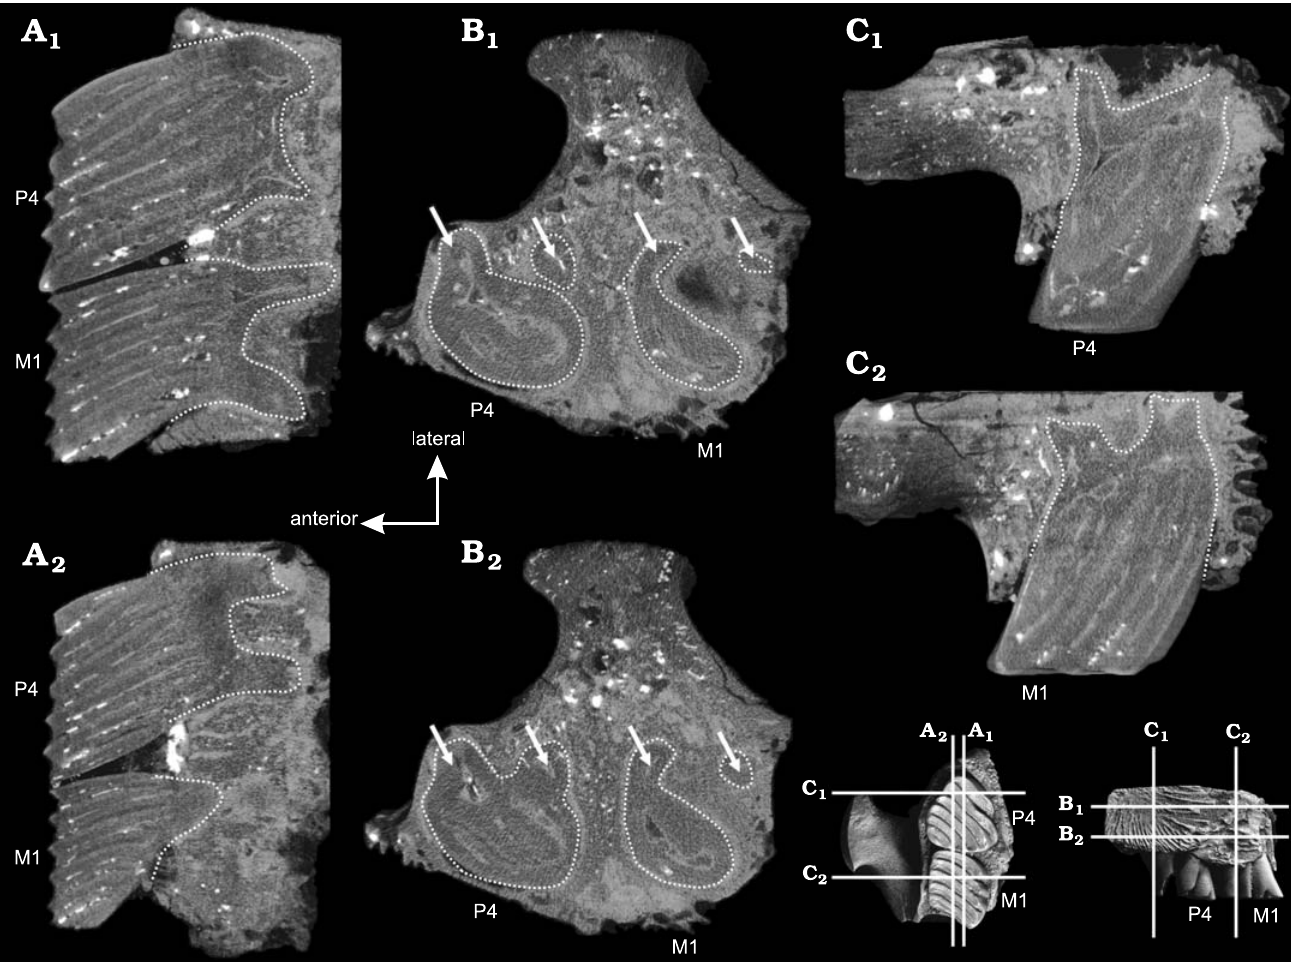
Fig. 6. CT-scan slices of the maxilla of potamarchine rodent Pseudo pota marchus villanuevai gen. et sp. nov. (UFAC 4762) from Solimões Formation, Late Miocene, Brazil; in longitudinal ( A ), horizontal ( B ), and transverse ( C ) planes, showing the labial roots of the cheek teeth